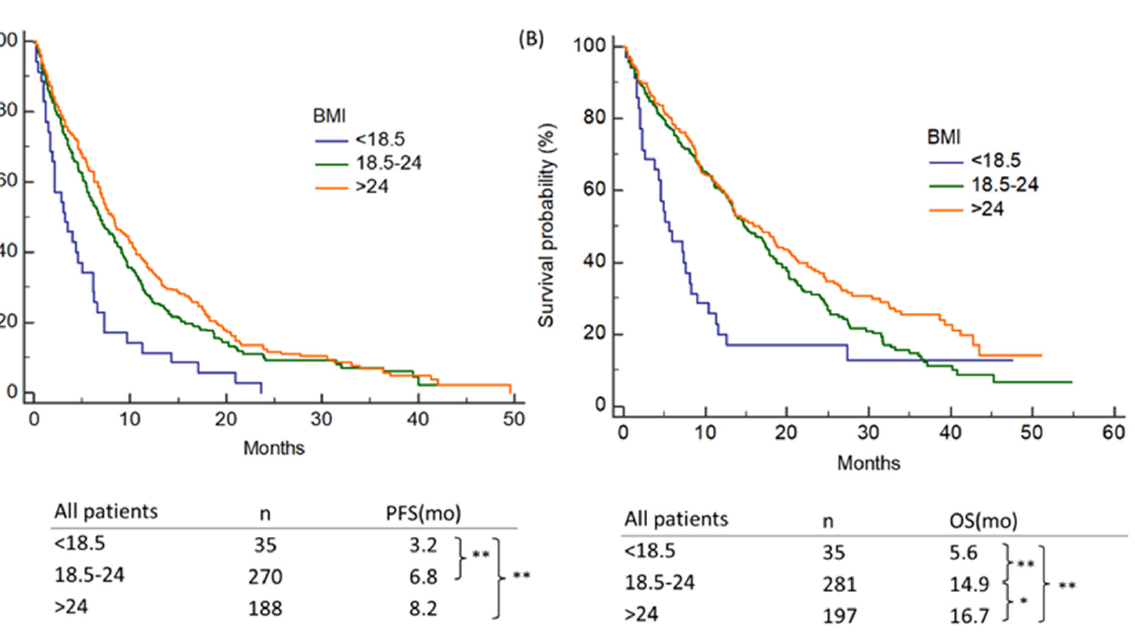
Figure 3. Influence of the baseline BMI on ( A ) PFS and ( B ) OS of NSCLC patients with wild-type EGFR status. BMI—body mass index; PFS—progression-free survival; OS—overall survival; NSCLC—non-small cell lung cancer; EGFR—epider- mal growth factor receptor; Note: * p < 0.05, ** p < 0.001. 3.6. Influence of Baseline BMI on Outcomes of NSCLC Patients with EGFR Mutation There was no difference in PFS between overweight, normal-weight, and under- weight patients among the EGFR mutant patients (Figure 4A). The overweight patients